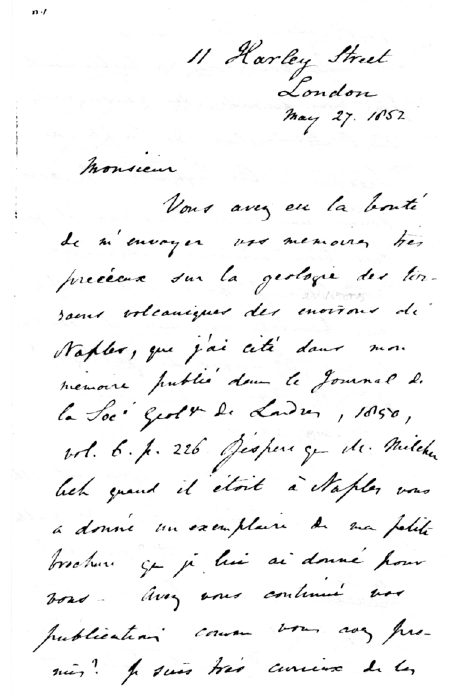
Fig. 2. Letters from Charles Lyell to Scacchi, Lon- don, 27 May 1852 (Biblioteca Fondazione Pomarici Santomasi, Gravina in Puglia (Bari, Italy), Cart. Scacchi, B 4, F 11, N